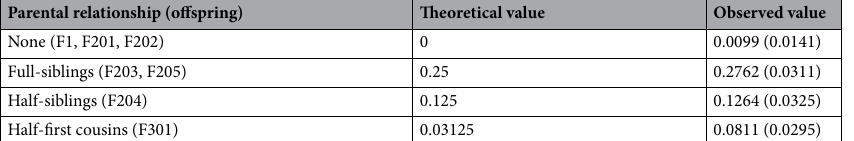
Table 3. Average individual inbreeding coefficients and standard deviations (in parentheses) estimated with different simulated pedigrees of offspring (in parentheses) from different types of parental relationships in comparison with the expected values. Offspring codes can be found in Supplementary Fig. S2. The values corresponding to each pedigree can be found in Supplementary Table